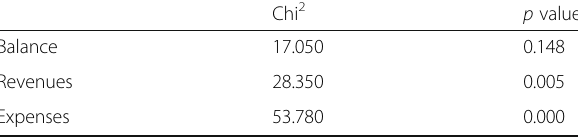
Table 11 Hausman test for random versus fixed effects